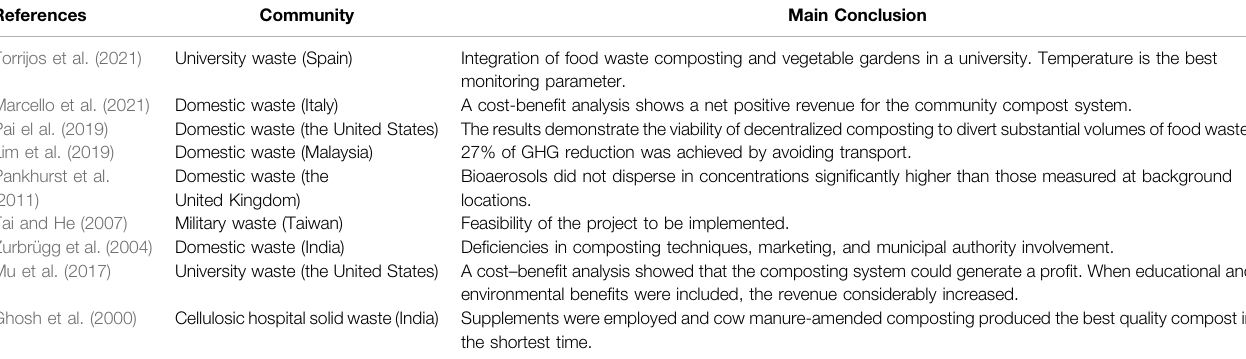
TABLE 1 | Experiences of community composting published in the